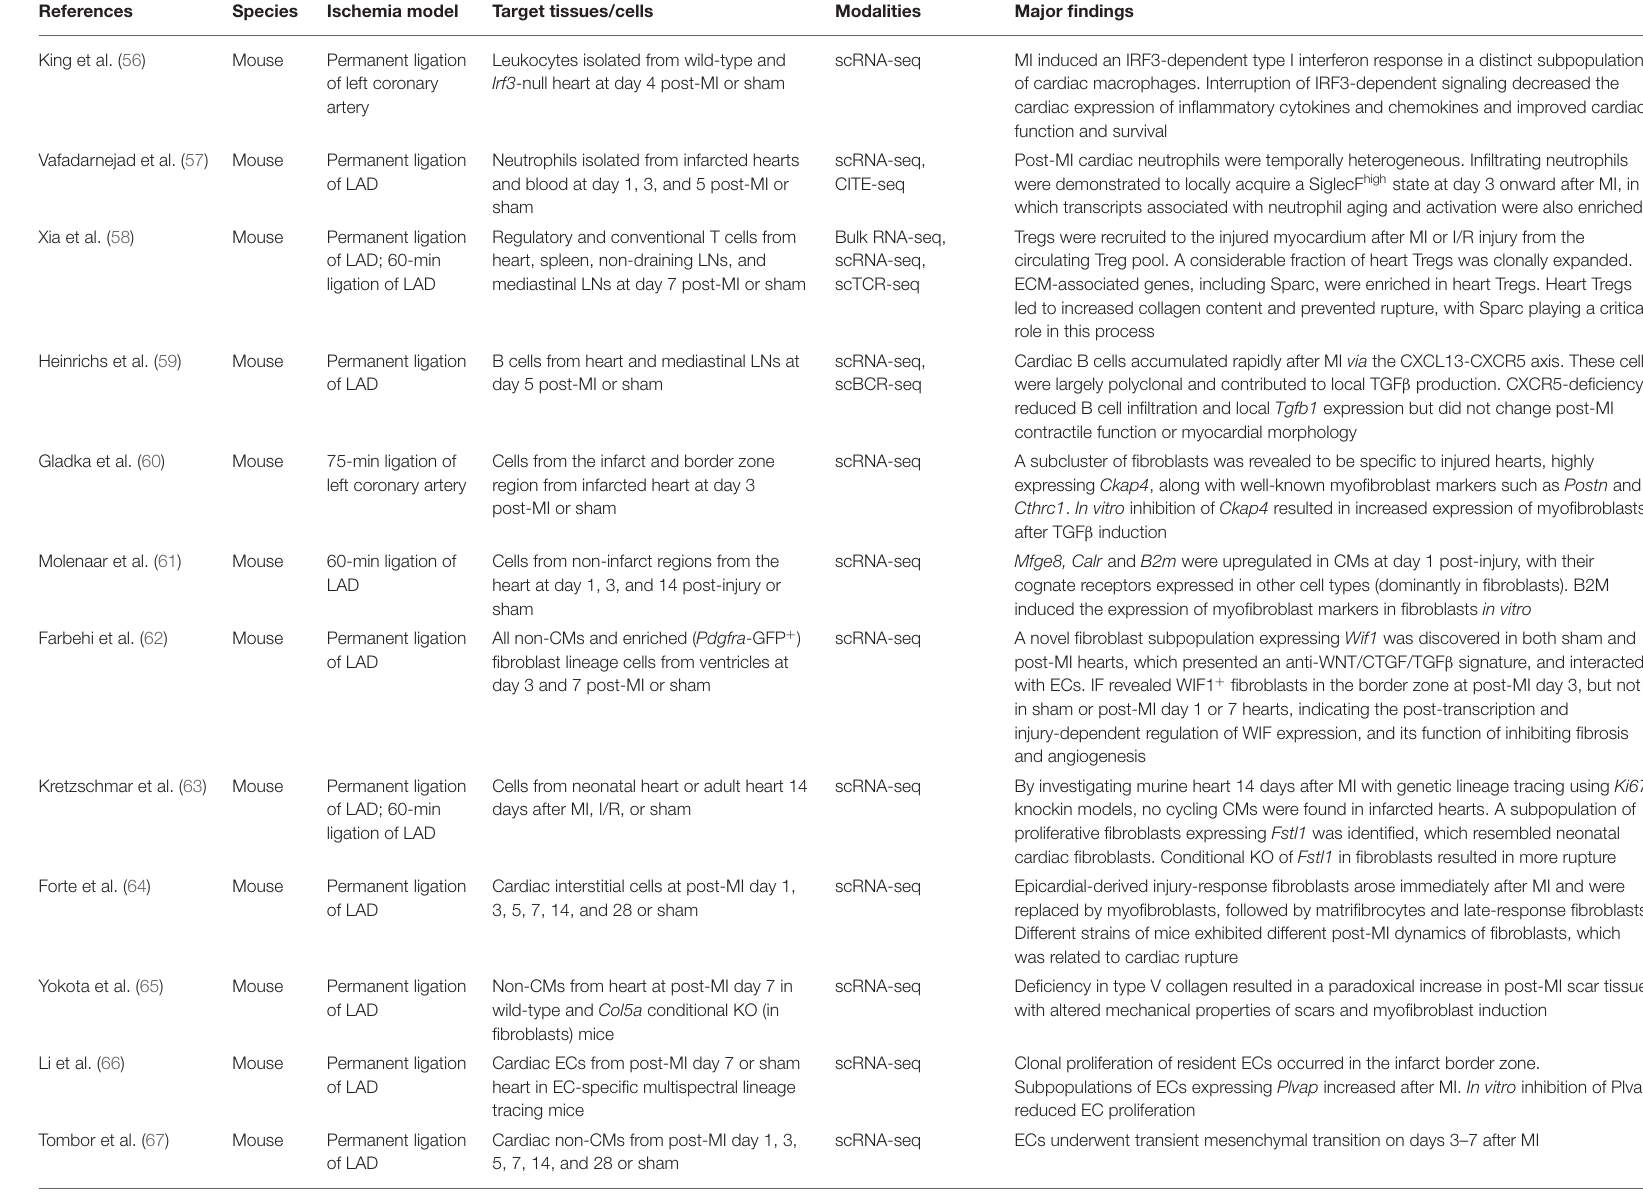
TABLE 3 | Summary of studies of myocardial infarction or ischemia-reperfusion